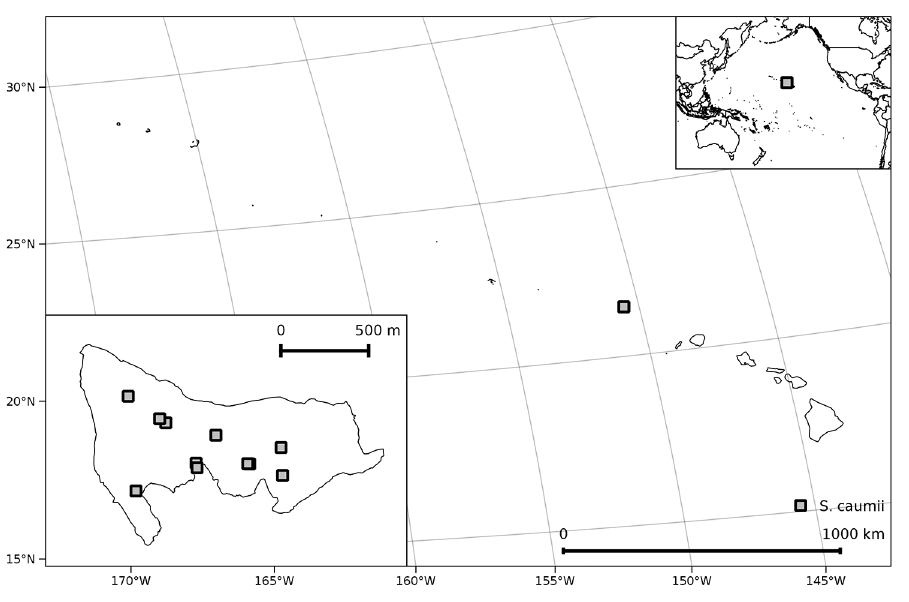
Figure 5. Distribution of Solanum caumii